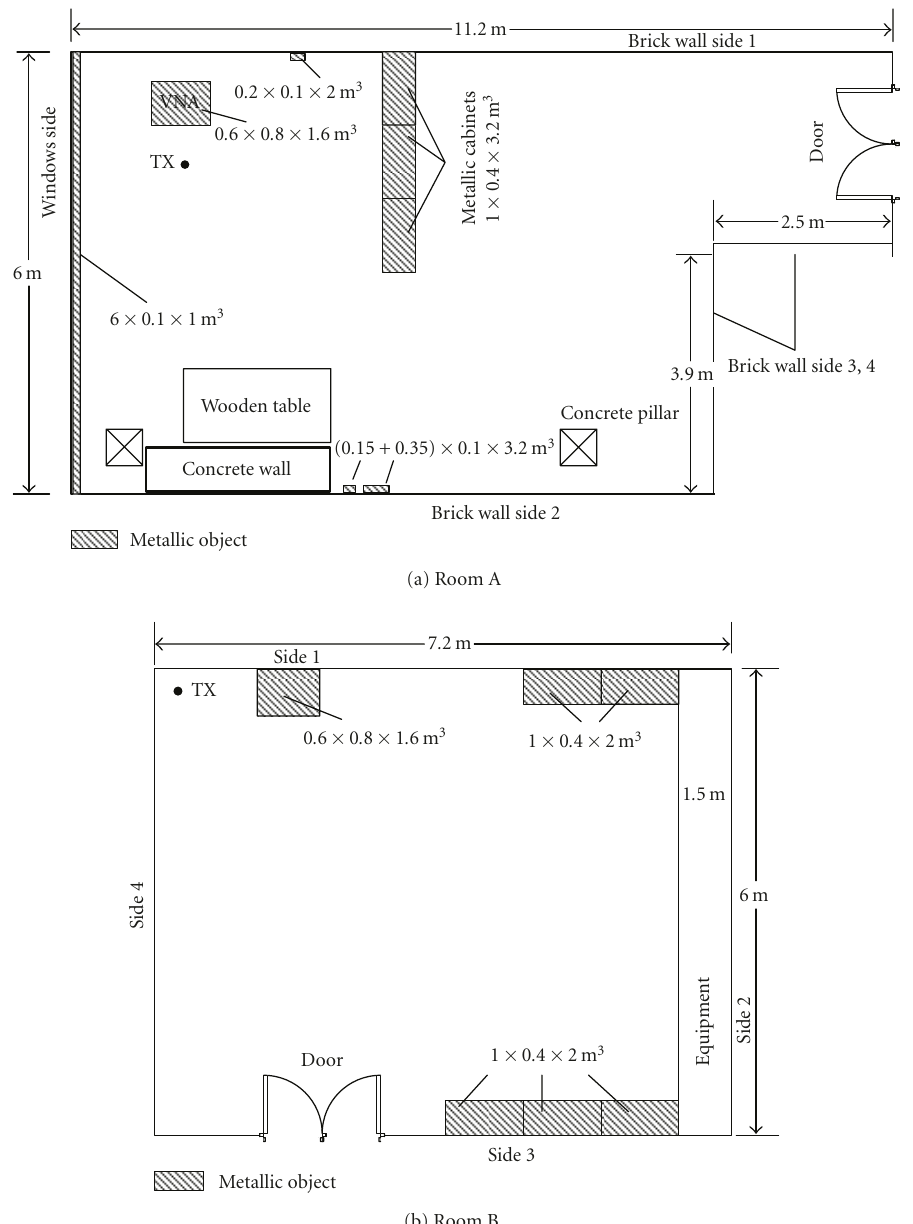
Figure 1: Plan view of the measured